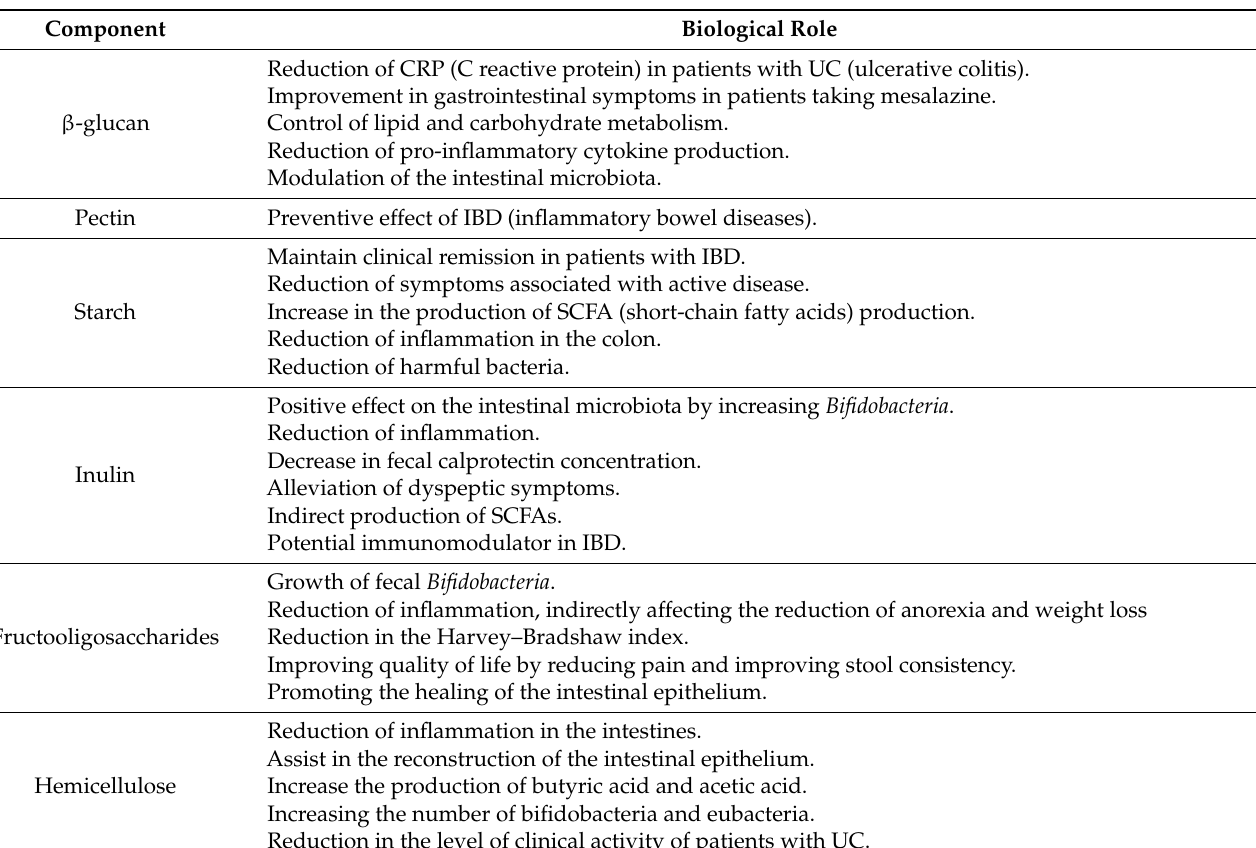
Table 1. Components of the fiber diet and their biological roles